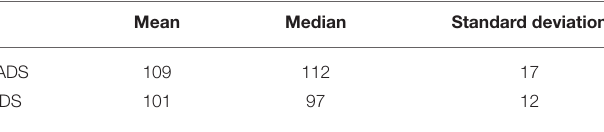
TABLE 4 | Mean, median, and standard deviation of vowel duration (ms) in ADS and IDS, calculated per participant. Mean Median Standard deviation